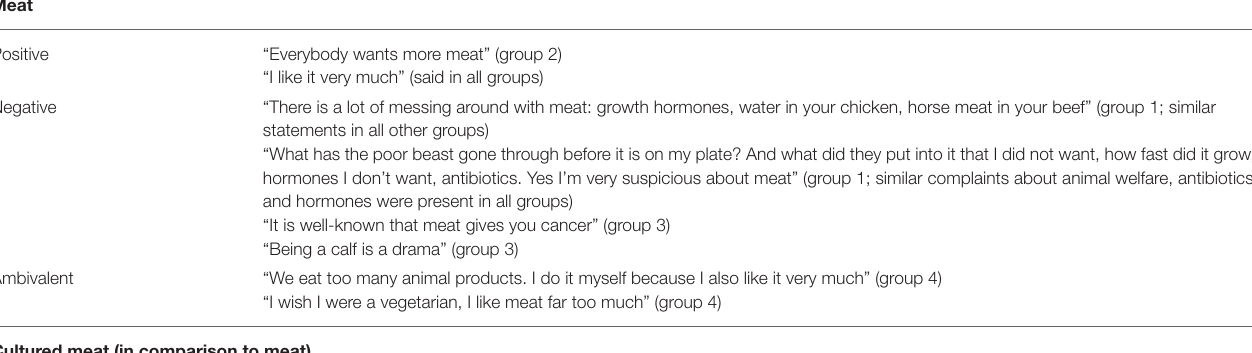
TABLE 3 | General statements on meat and cultured meat.